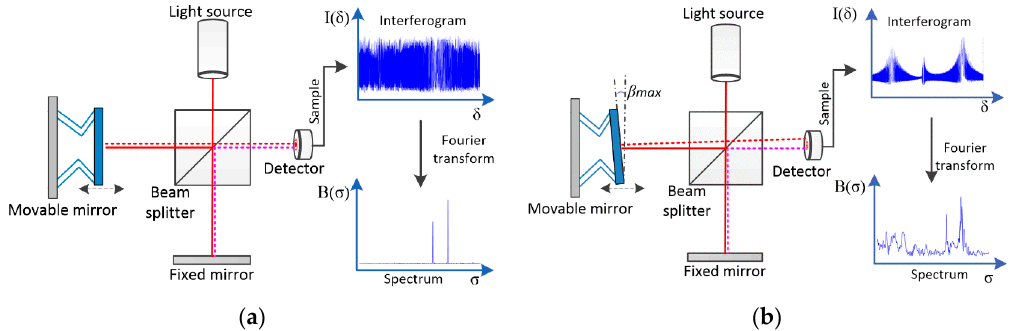
Figure 1. ( a ) An ideal FTS system; ( b ) An FTS system with the moving mirror